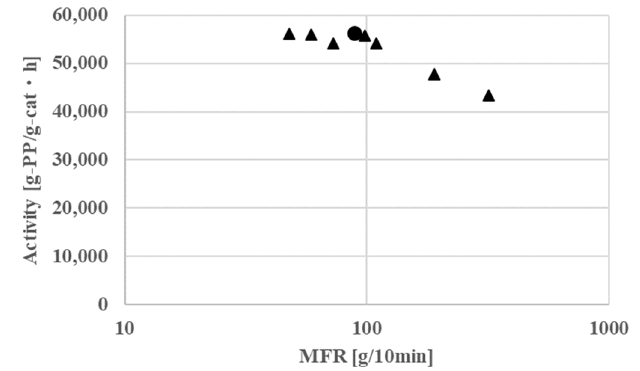
Figure 2. Relationship between MFR vs Activity; ● : U-donor, ▲ : Alkyl triethoxyalkylsilanes ( 1 – 7 ).